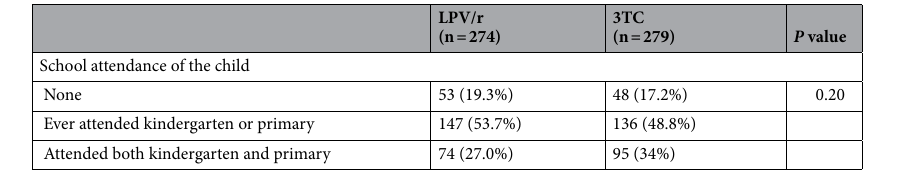
Table 1. Characteristics of ANRS12174 trial participants who subsequently enrolled in the M&S study by treatment group (N = 553). LPV/r lopinavir-ritonavir, 3TC lamivudine, PMTCT prevention of mother to child transmission, WAZ weight-for-age Z-score, LAZ length-for-age Z-score, WLZ weight-for-length Z-score, BMI body mass index. † 2 Missing data. ‡ 4 Missing data. ¤¤ 7 Missing data. ££ 29 Missing data. # 27 Missing data. ¥¥ 30 Missing data. ¥ 38 Missing data. £ 39 Missing data. ++ 46 Missing data. + 47 Missing data. ¤ 48 Missing data. µ 49 Missing data. ¤¤ 50 Missing data. µµ 52 Missing